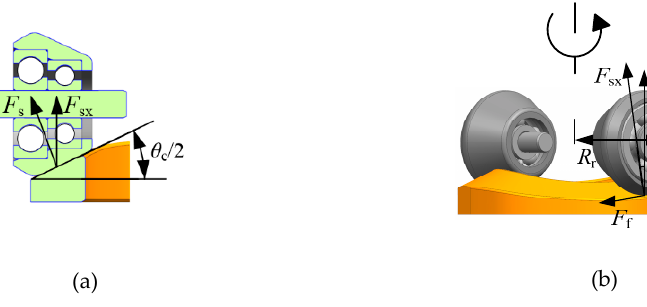
Figure 6. Force analysis of the cone rollers on the left driving set when the driving set rotates from 0 degrees to 45 degrees. ( a ) Axial component force of the supporting force on the cone roller; ( b ) force analysis of the cone rollers on the guiding rail.